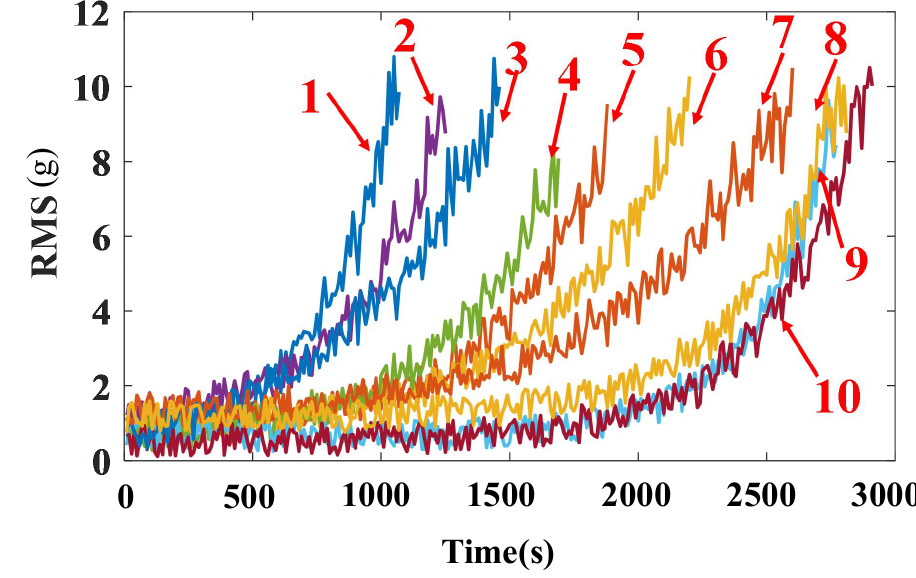
Figure 7. Ten examples of the generated data by the exponential model. Different color curves represent different run-to-failure data. The number 1,2,3,......,10 denotes the generated run to failure data of bearing 1 to 10. The horizontal axis shows the inspection time. The vertical axis shows the value of